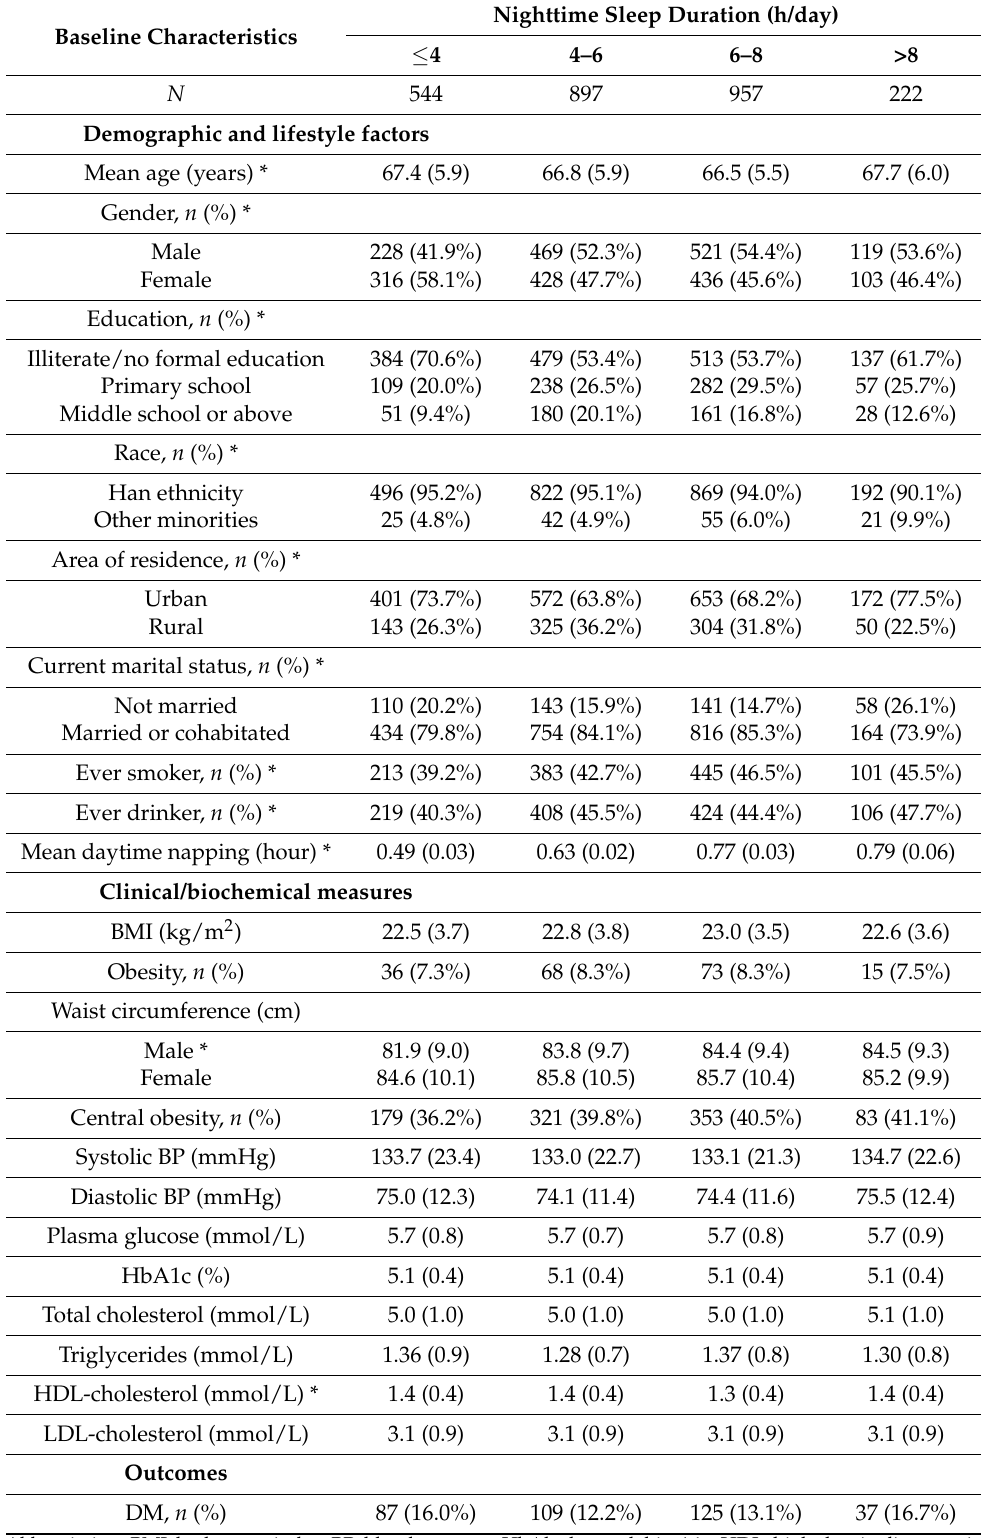
Table 2. Comparison of baseline characteristics according to different nighttime sleep